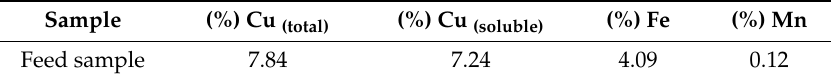
Table 1. Chemical composition of the copper oxide sample (initial sample).